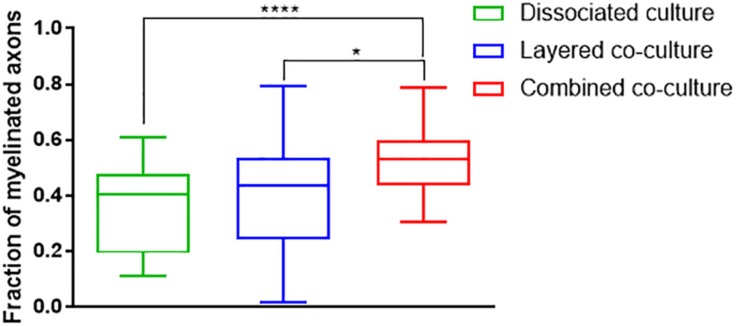
Fraction of Phosphorylated neurofilament which is colocalized with PLP/DM20 used to indicate the proportion of axonal area with a myelin sheath. Data acquired at 35 days in co-culture (n = 3, ∗p < 0.05, ****p < 0.0001).